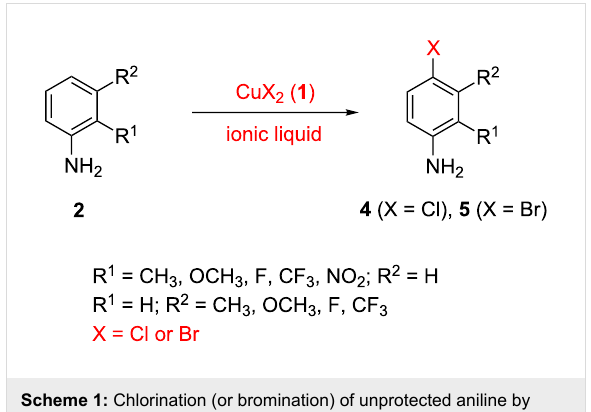
Table 1: Exploring solvents and other conditions for the chlorination of 2-methylaniline ( 2a , 10 mmol scale) using CuCl 2 . a